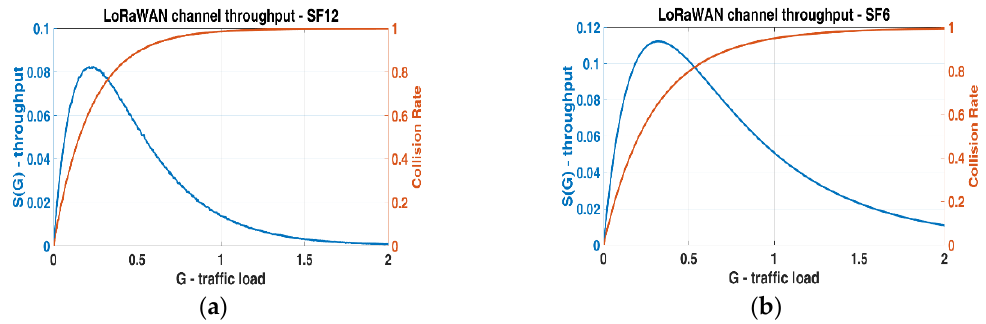
Figure 6. Confirmed LoRaWAN throughput and collision rate for one channel acquired by MATLAB simulation. ( a ) SF = 12, BW = 125 KHz, CR = 4 Maximum throughput is 8%; ( b ) SF = 6, BW = 125 KHz, CR = 4 Maximum throughput is